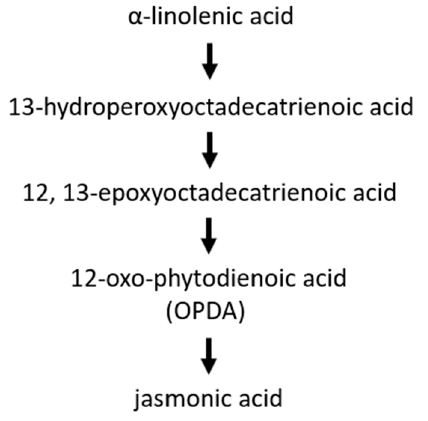
Figure 6 . Jasmonic acid biosynthesis . Figure 6. Jasmonic acid